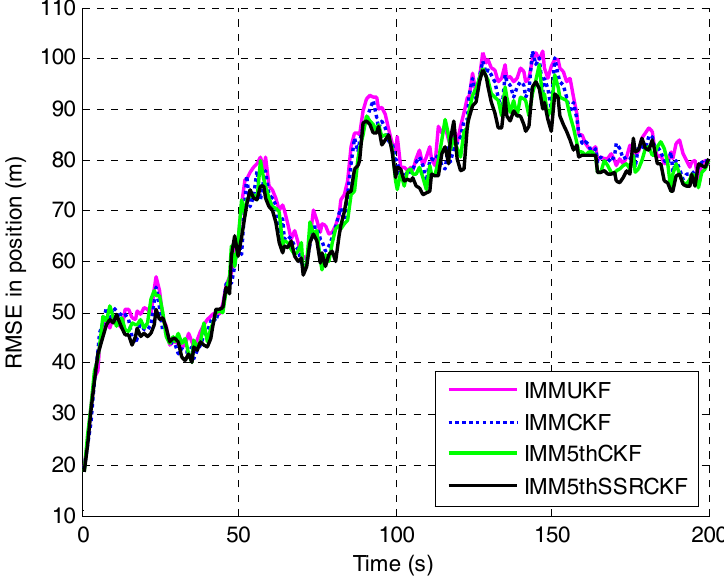
Figure 3. RMSE in position versus time step.